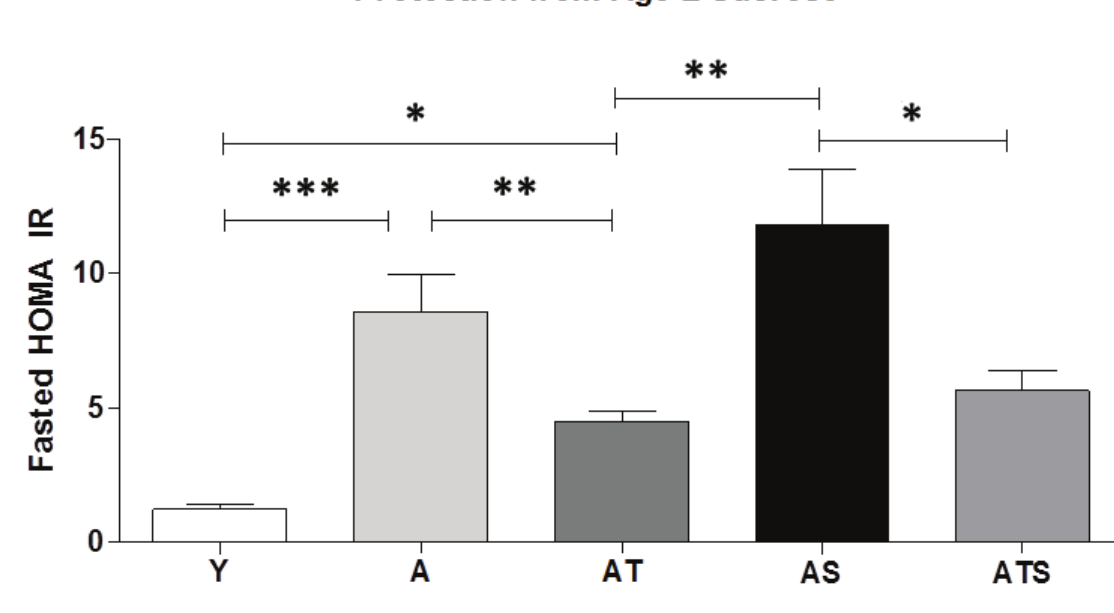
Figure 3. SAMEC protection from the effects of age ± sucrose supplementation on the homeostatic model assessment (HOMA). The HOMA-IR data showed protection by SAMEC in aged ± sucrose-supplemented groups. * p < 0.05; ** p < 0.01; *** p <